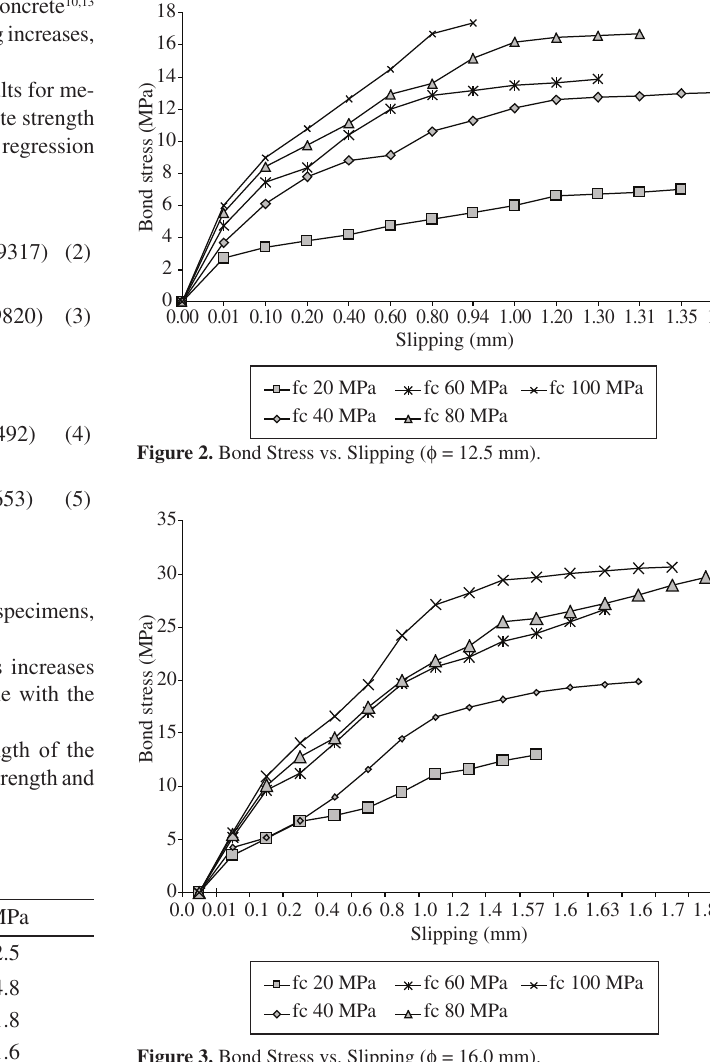
Figure 3. Bond Stress vs. Slipping ( f = 16.0